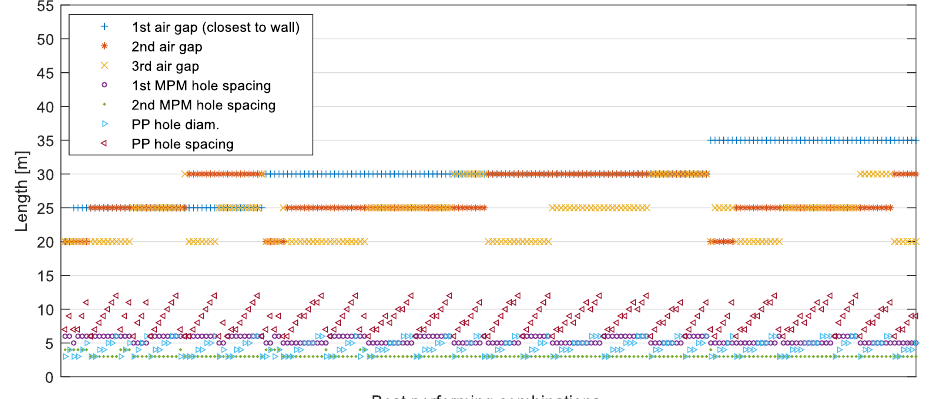
Figure 11. Plot of best 200 combinations of the seven input parameters returned by the optimization and yielding an average absorption coefficient (calculated over the one-third octave bands from 400 Hz to 2.5 kHz) within 2% of the maximum, equal to 0.81.